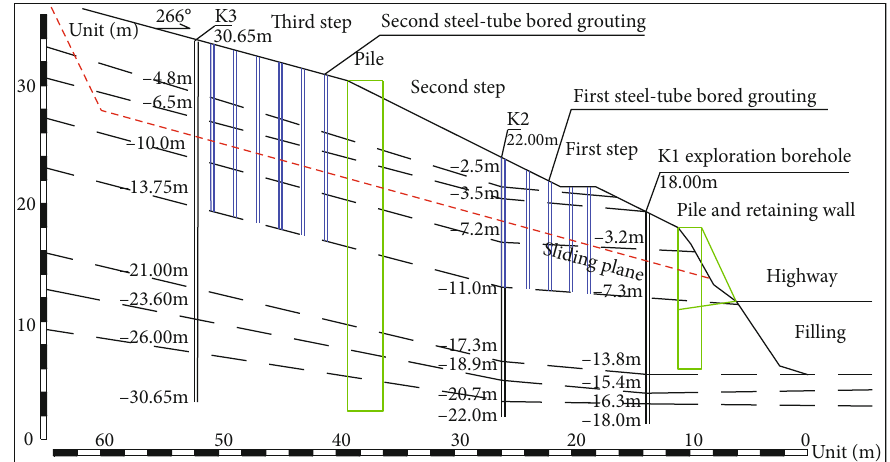
Figure 9: Grouting reinforcement